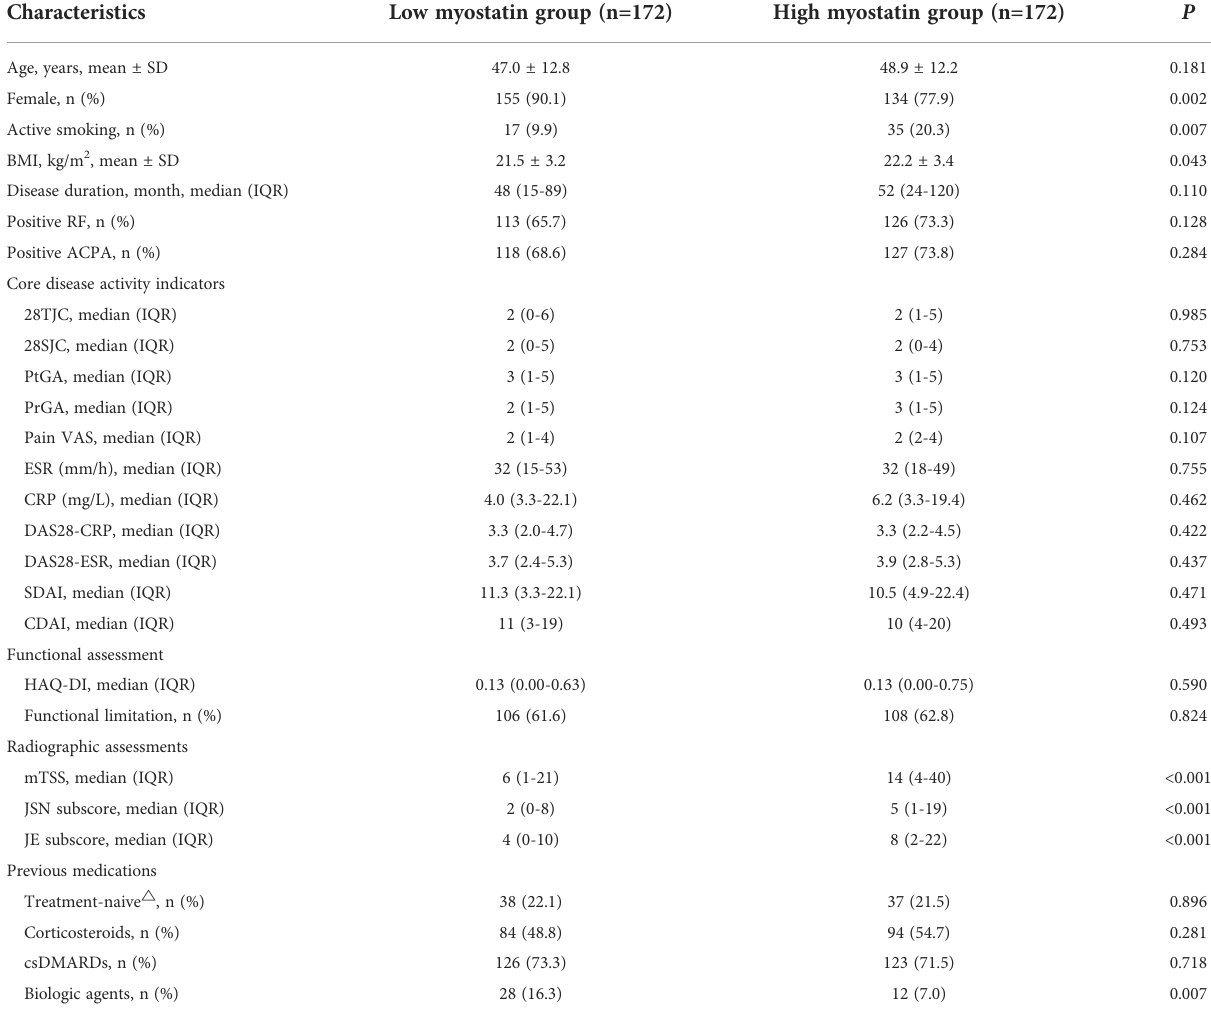
TABLE 2 Comparison of baseline characteristics between RA patients with low and high baseline serum myostatin.